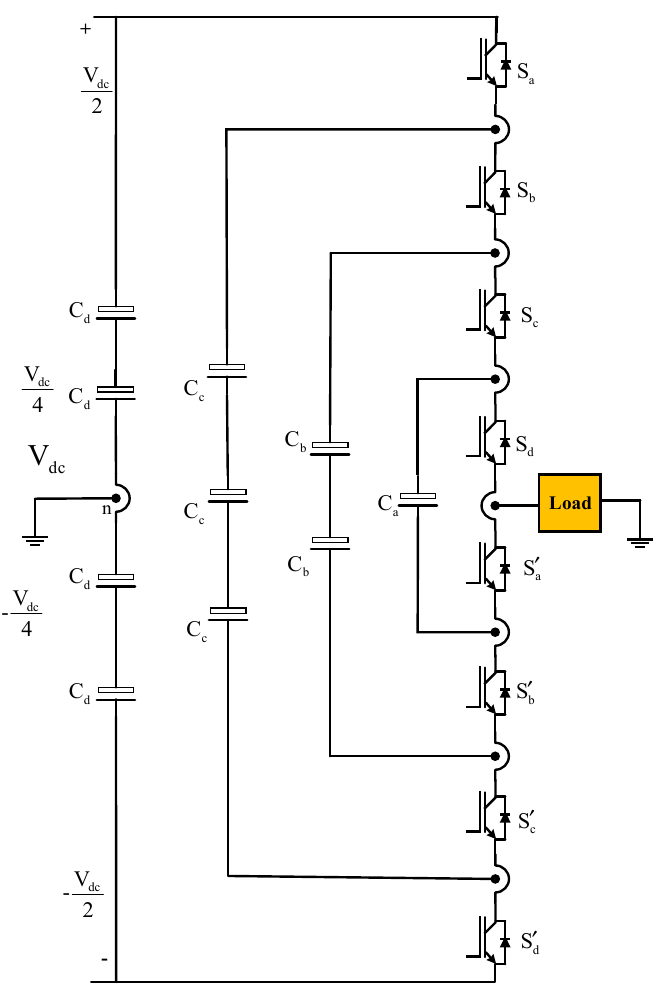
Figure 4. Multilevel (Five-level) capacitor clamped/flying capacitor inverter.